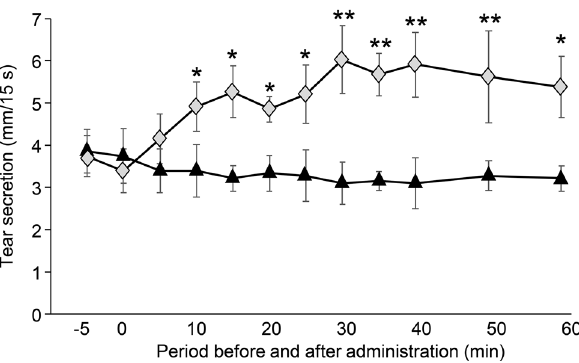
Figure 4. Effect of molecular hydrogen (H 2 ) on the tear secretion in non-stressed mice. All results are expressed as the mean ± standard deviation (n = 5). Significant differences from the vehicle group are indicated by * p < 0.05 or ** p < 0.01 . Black triangle: vehicle, grey diamond: SUPER H2 (H 2